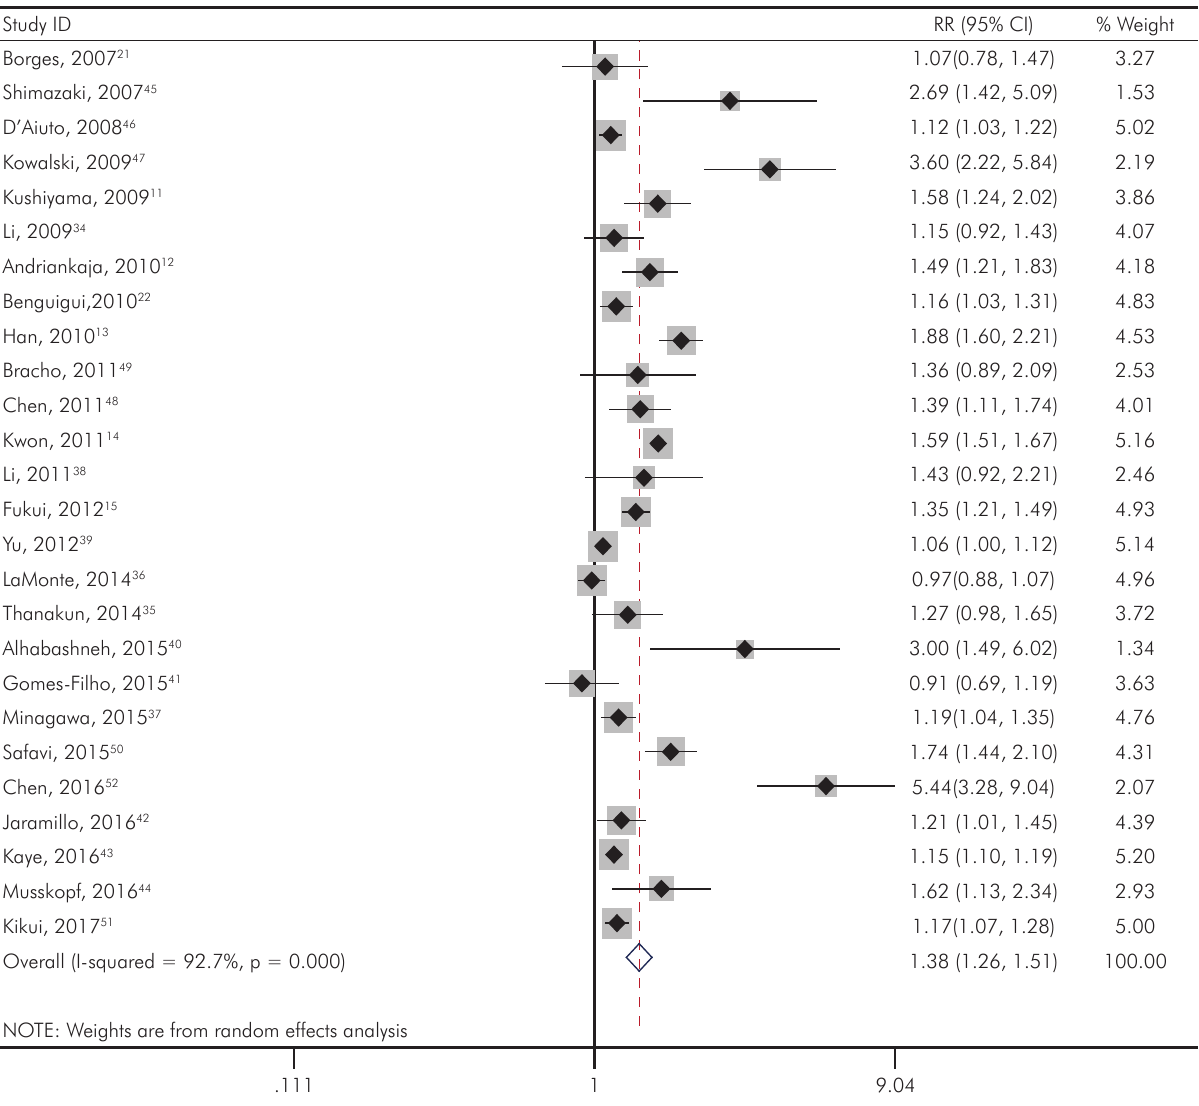
Figure 2. Meta-analyses of the association between periodontal diseases and metabolic